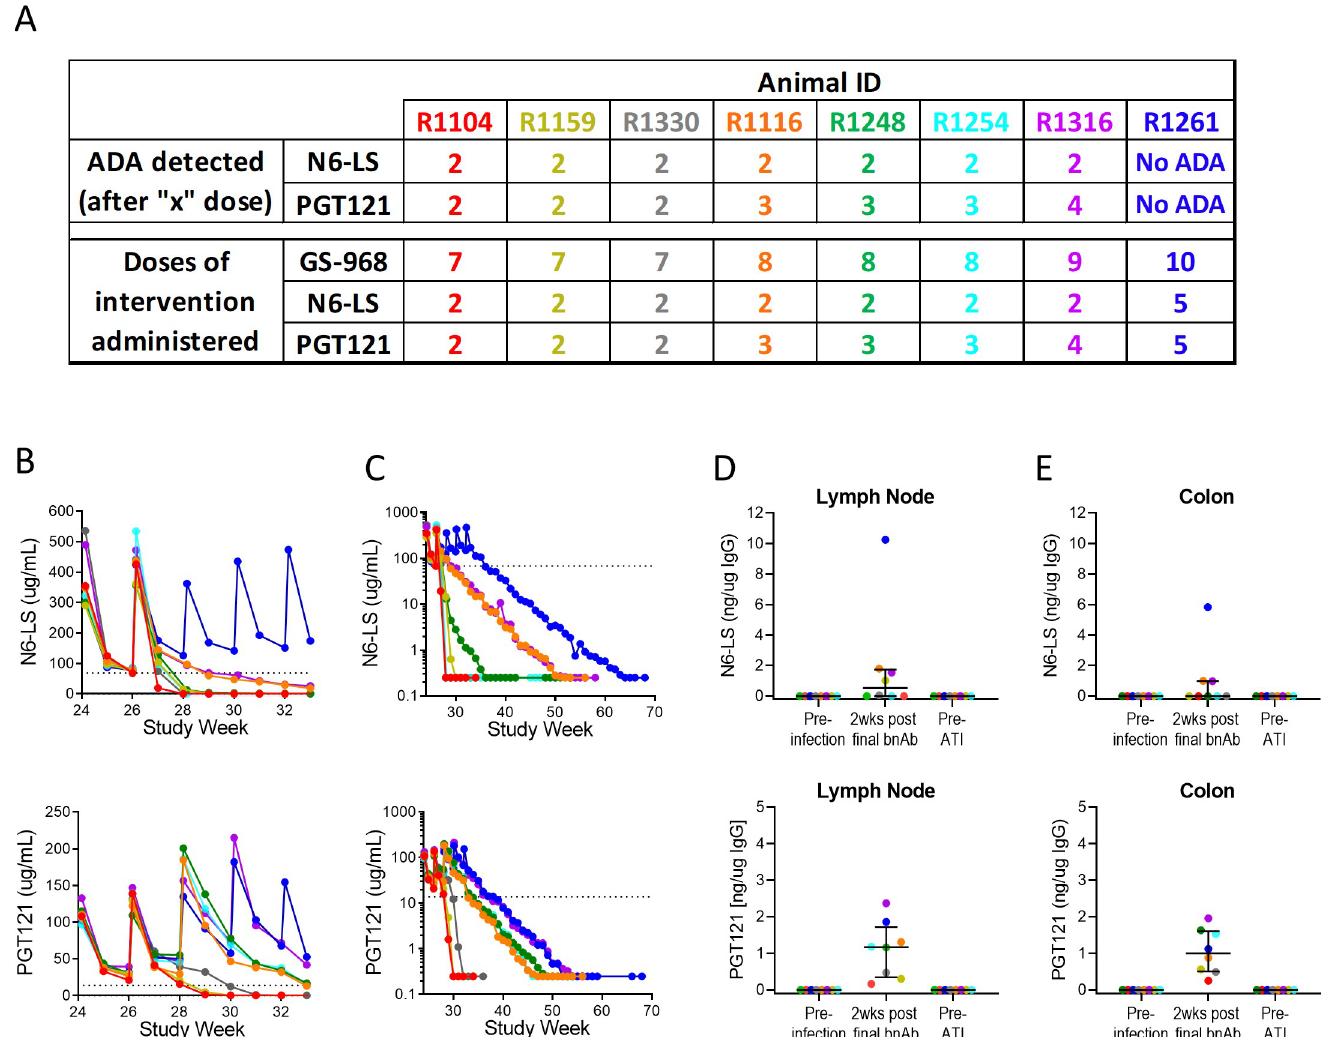
Fig 4. Plasma and tissue levels of N6-LS and PGT121. (A) The number of doses of GS-986, N6-LS and PGT121 administered to each animal varied as no further broadly neutralizing antibody (bnAb) was administered after the detection of anti-drug-antibody (ADA) to the respective bnAb. (B) Peak and trough plasma N6-LS and PGT121 levels during wks 24–33 are shown for each individual animal. Dotted lines represent 100x predicted IC80 levels for SHIV-1157ipd3N4 (0.689 ug/mL for N6-LS and 0.139 ug/mL for PGT121). (C) Plasma levels of both bnAbs were monitored weekly and ART was interrupted when levels for both bnAbs became < 0.25 ug/mL. At the time of ART interruption (ATI), N6-LS and PGT121 were both undetectable in (D) lymph node or (E) colon. Lines and error bars represent median and interquartile range